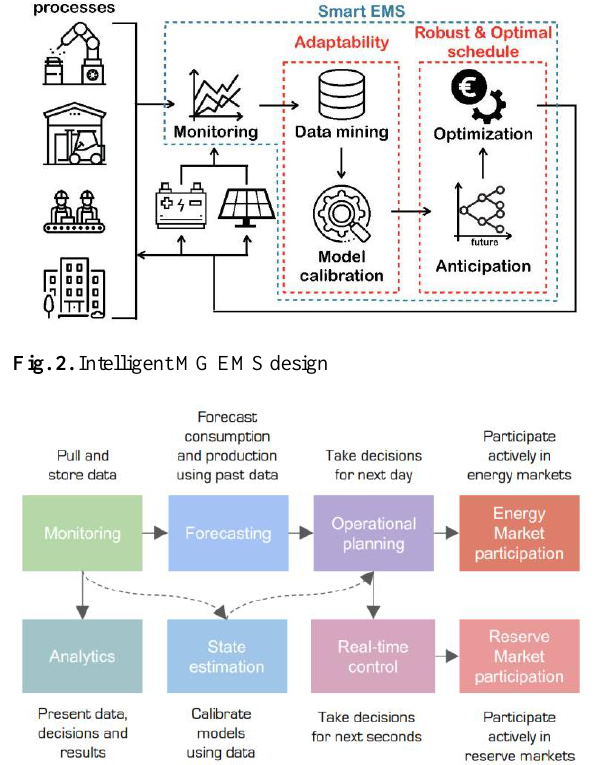
Fig. 3. Functional modules for energy microgrids management